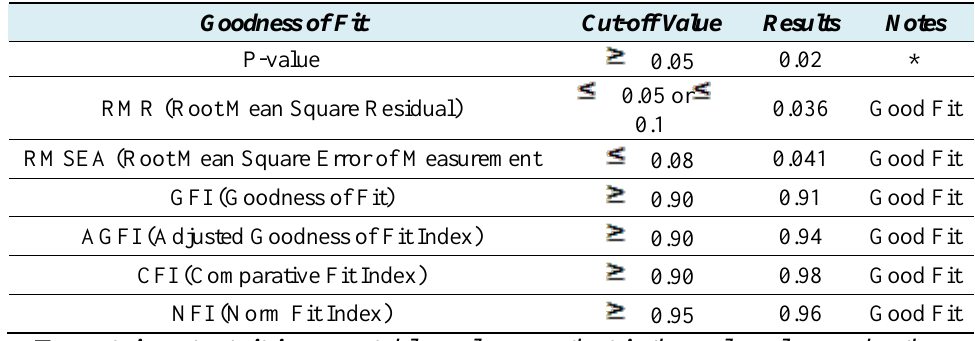
The goodness of fit of the model Goodness of Fit Cut-off Value Results Notes P-value 0.05 0.02 * 0.05 or RMR (Root Mean Square Residual) RMSEA (Root Mean Square Error of Measurement AGFI (Adjusted Goodness of Fit